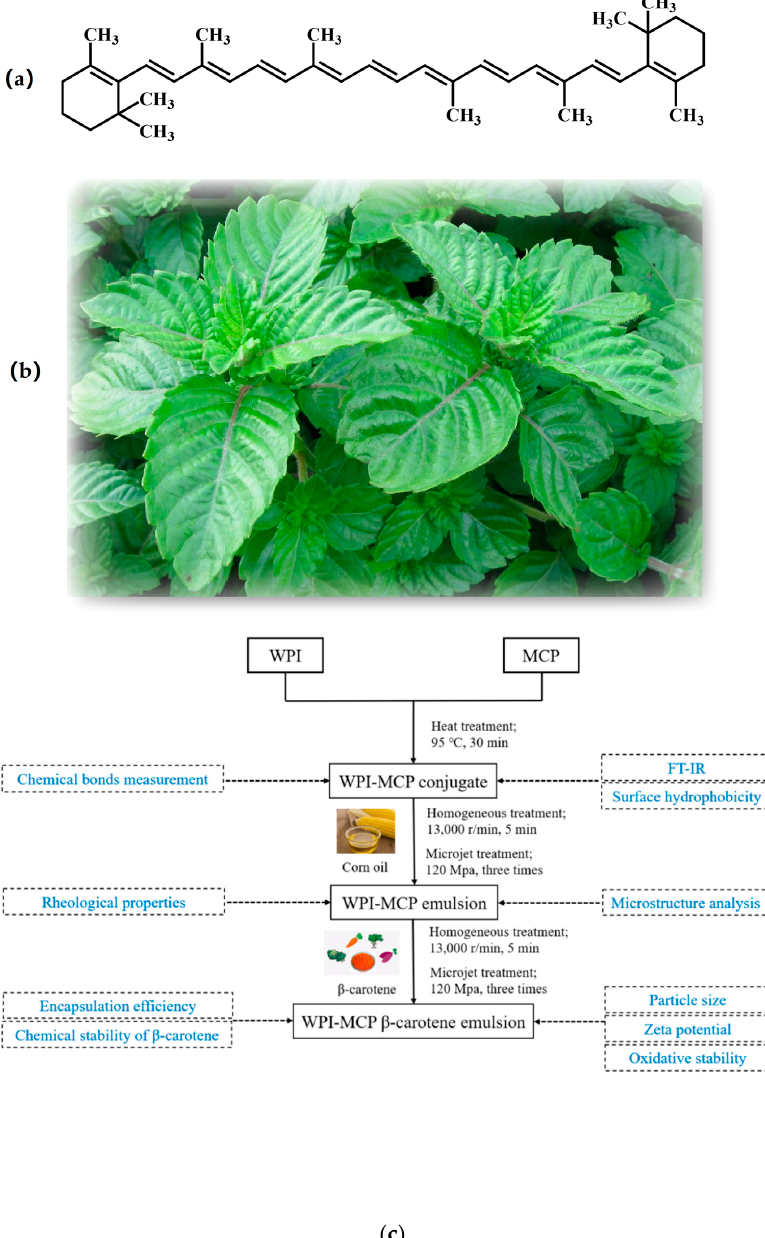
Figure 1. The chemical structure of β‐ carotene ( a ) and appearance of Mesona chinensis Benth ( b ). ( c ) Overall experimental plan.